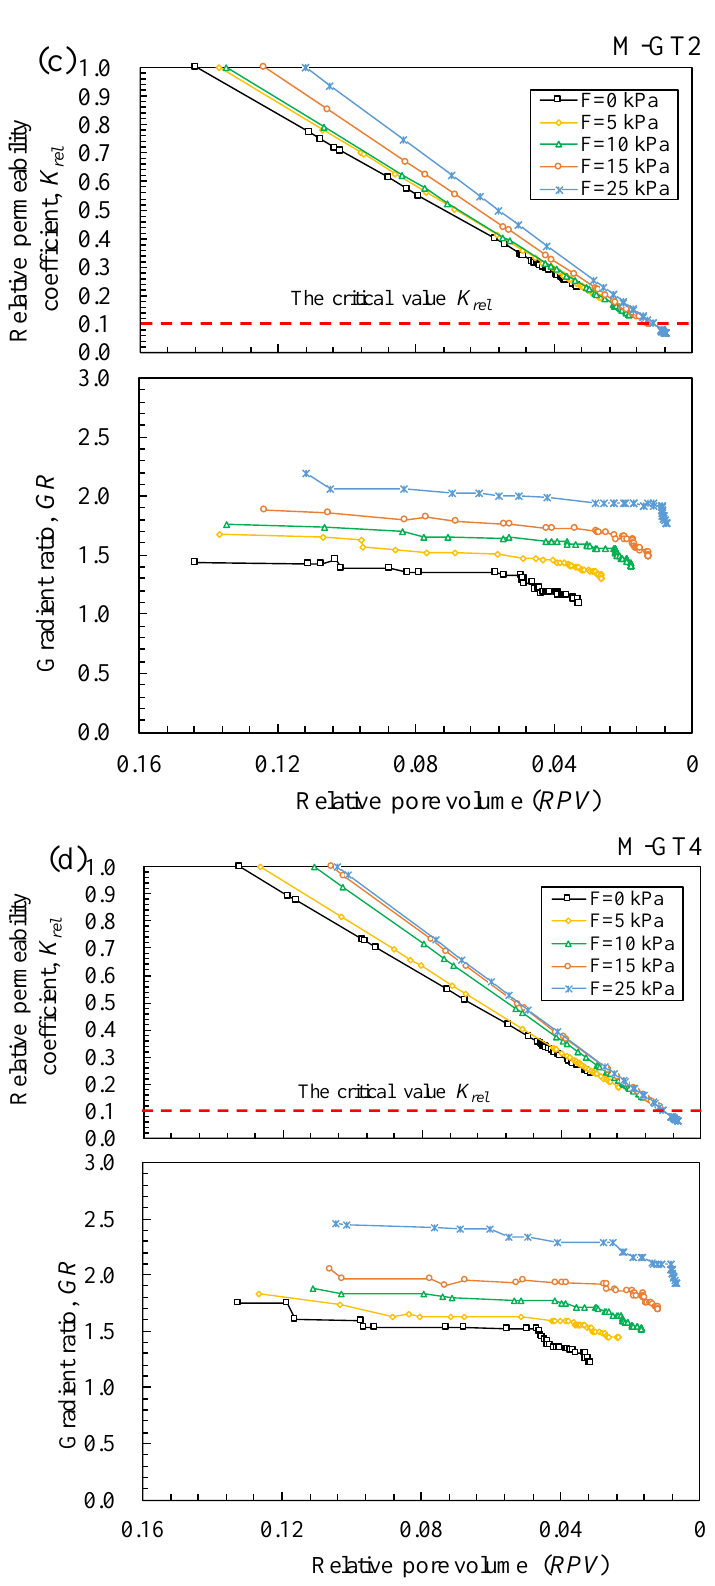
Figure 10. The K rel and GR versus relative pore volume (RPV ) for two natural soils filtered by GT2 and GT4: ( a ) C-GT2 combination; ( b ) C-GT4 combination; ( c ) M-GT2 combination; ( d ) M- GT4